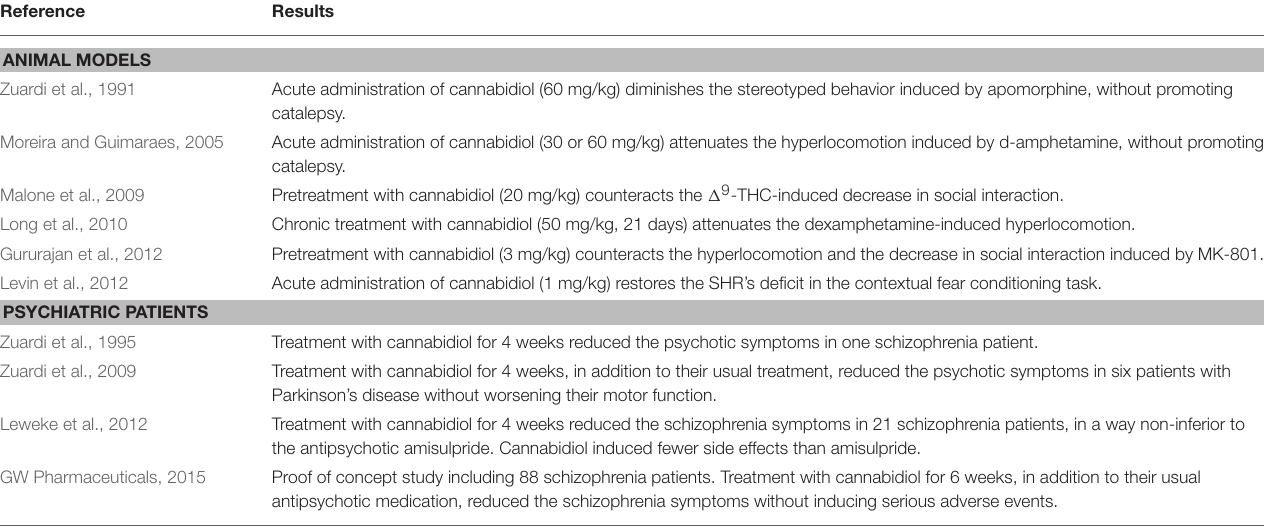
TABLE 3 | Antipsychotic effects of cannabidiol in psychiatric patients and in schizophrenia-like behaviors in animal models (for PPI, see Table 2).